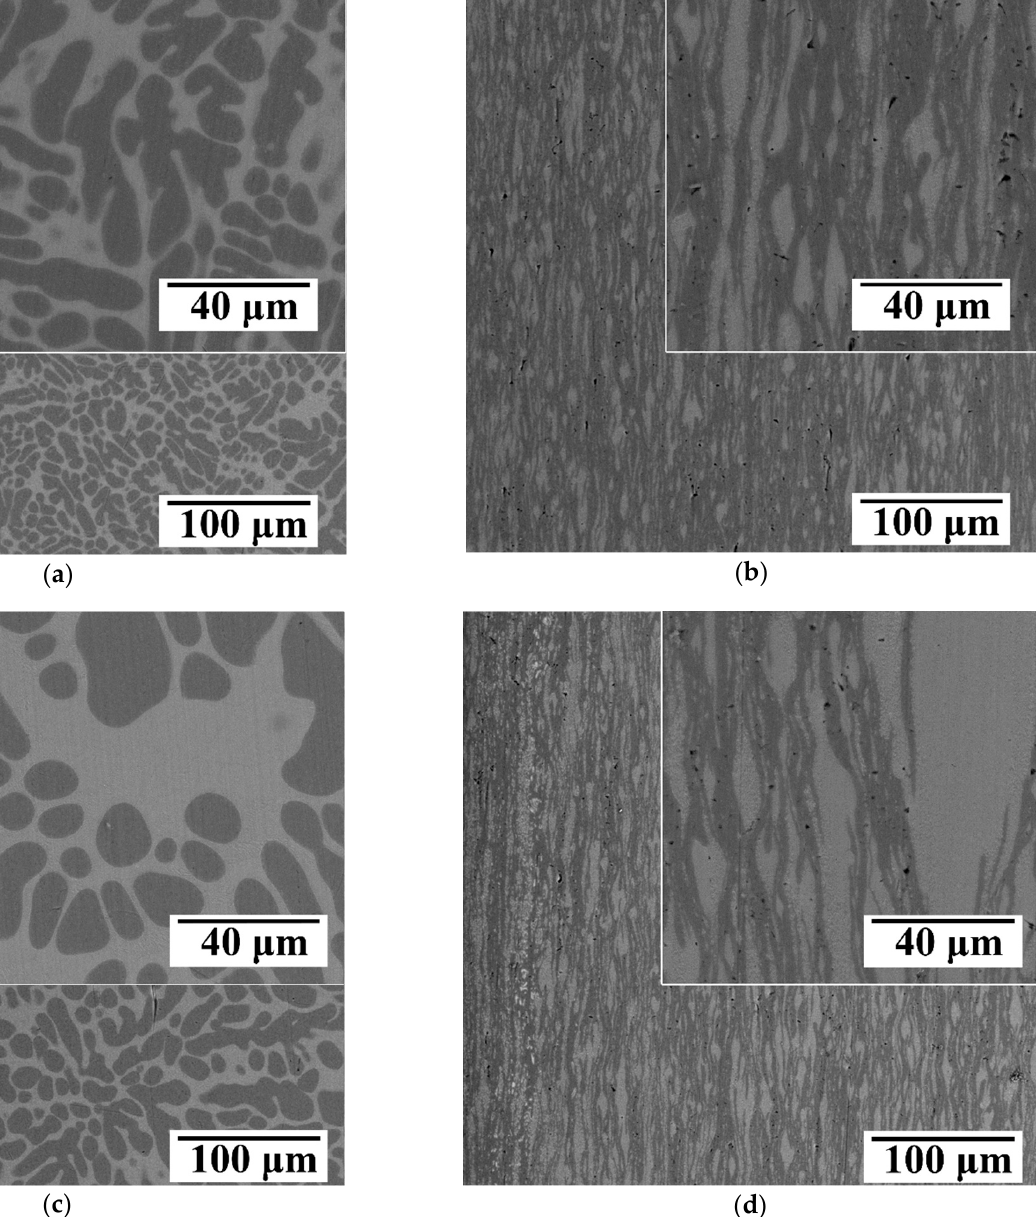
Figure 11. SEM microstructure of the alloys: ( a , b ) Al3Ca0.5Cu, ( c , d ) Al3Ca1Cu, ( a , c ) as-cast, ( b , d ) hot rolled at 300 °C.